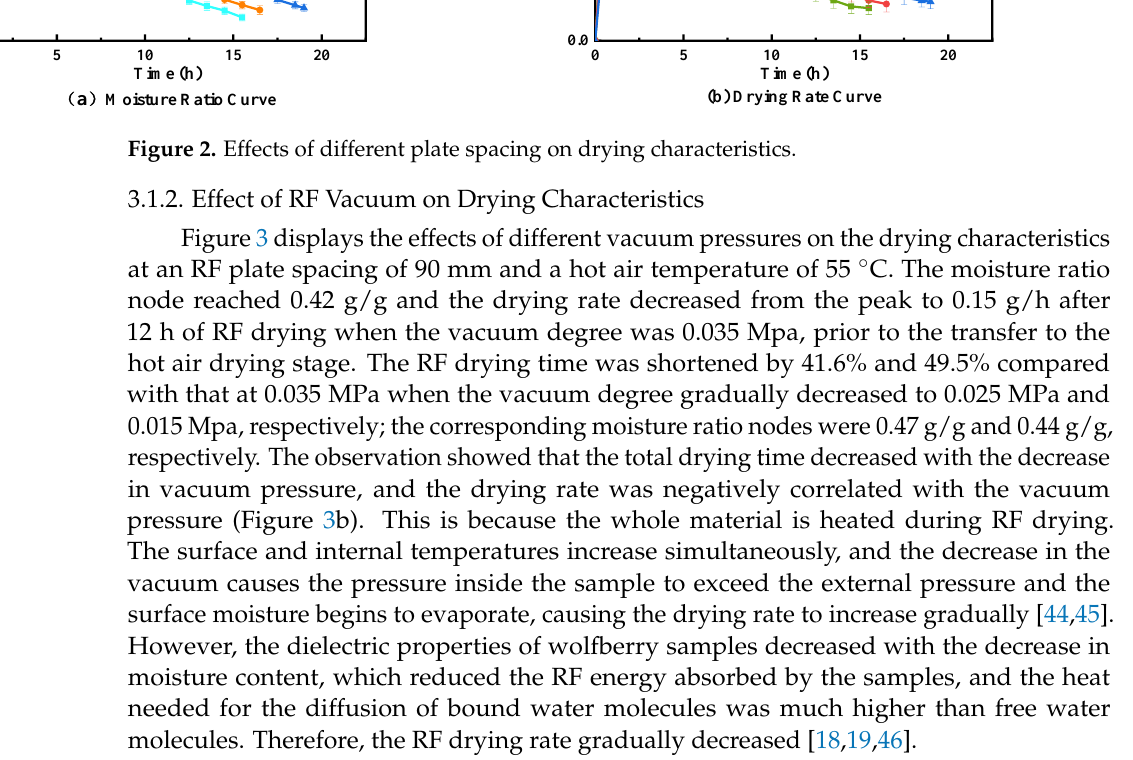
Figure 2. Effects of different plate spacing on drying characteristics.